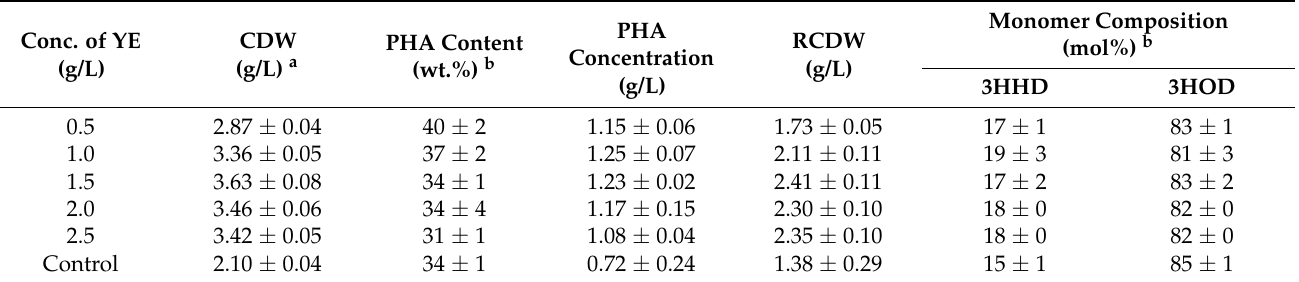
Table 4. Effect of yeast extract concentration on the growth and PHA biosynthesis by Acinetobacter sp. strain